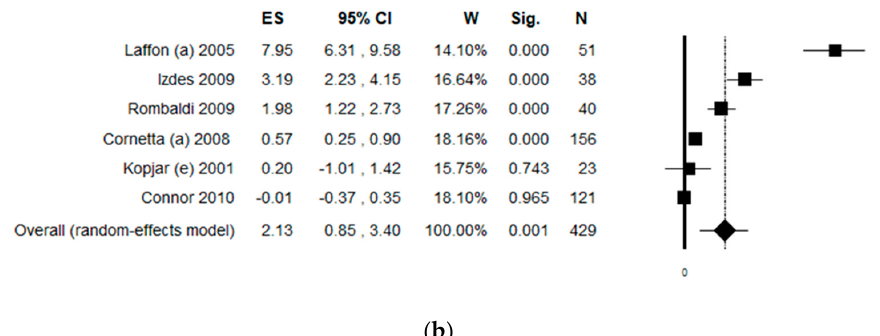
Figure 6. Forest plot of the sub-group analysis by protective equipment used assessing the comet assay on lymphocytes cells among professionals occupationally exposed to antineoplastic drugs (ANDs). ( a ) Without any equipment or at least gloves and masks; ( b ) using at least gloves, masks, and air-flow cabinet.